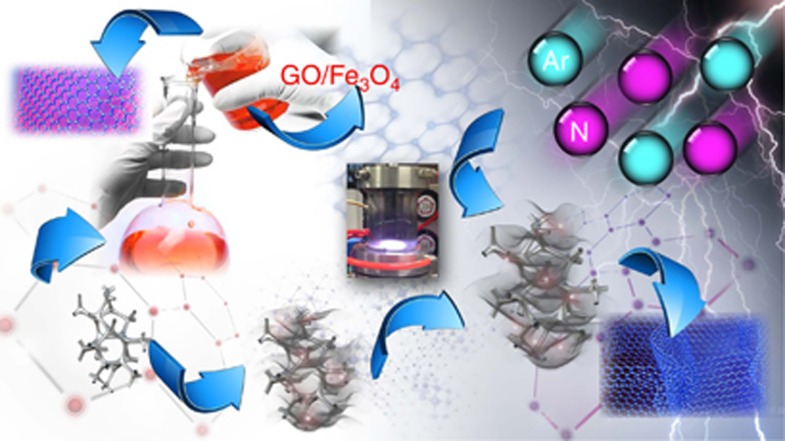
Schematic illustration of the synthetic procedures for NG/Fe3O4.